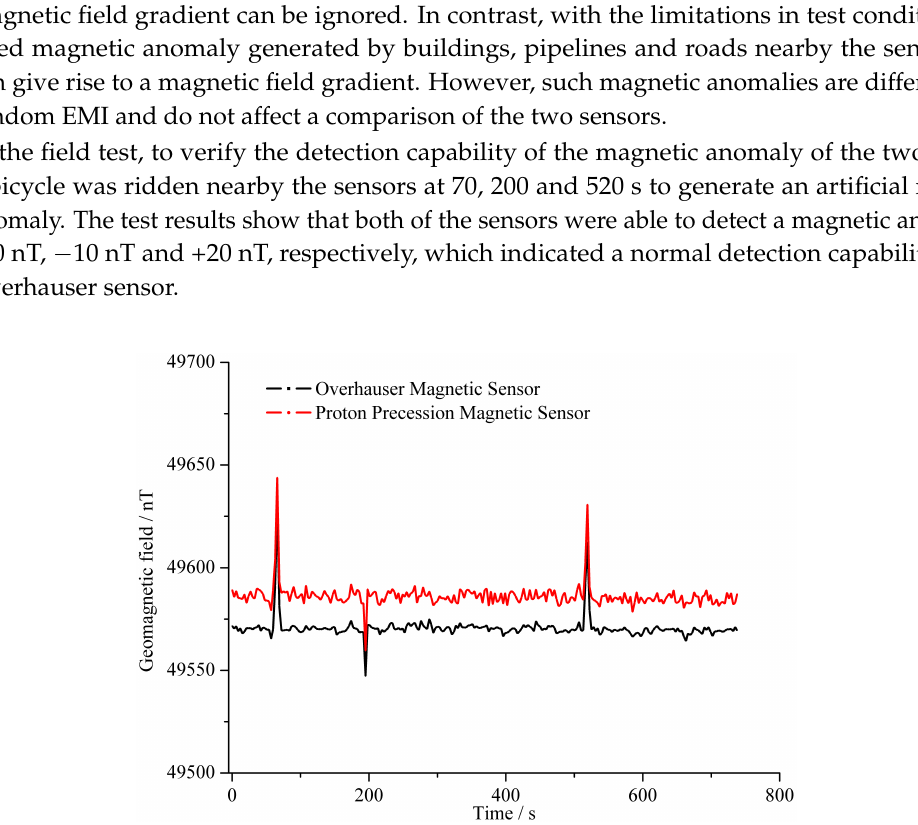
Figure 16. Contrast results of the geomagnetic field measurement between two